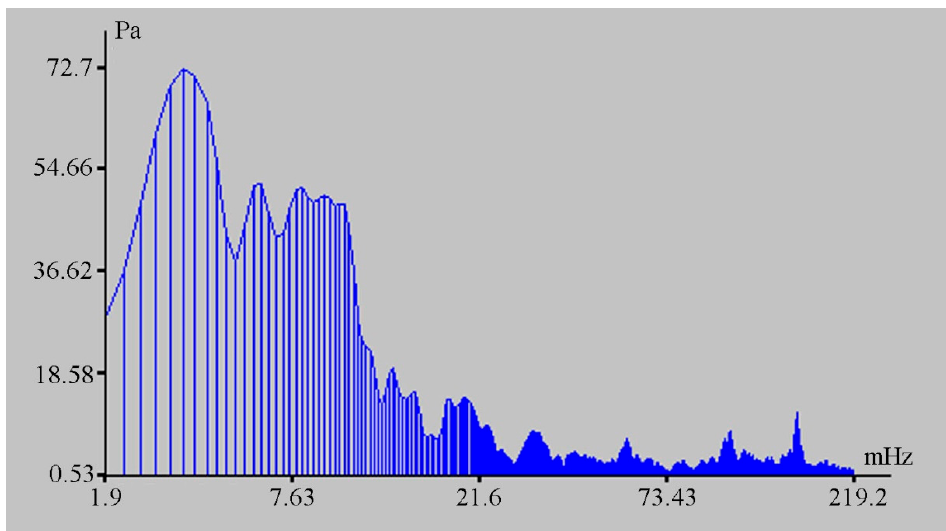
Figure 9. Spectrum of the detector of hydrosphere pressure variations record fragment.